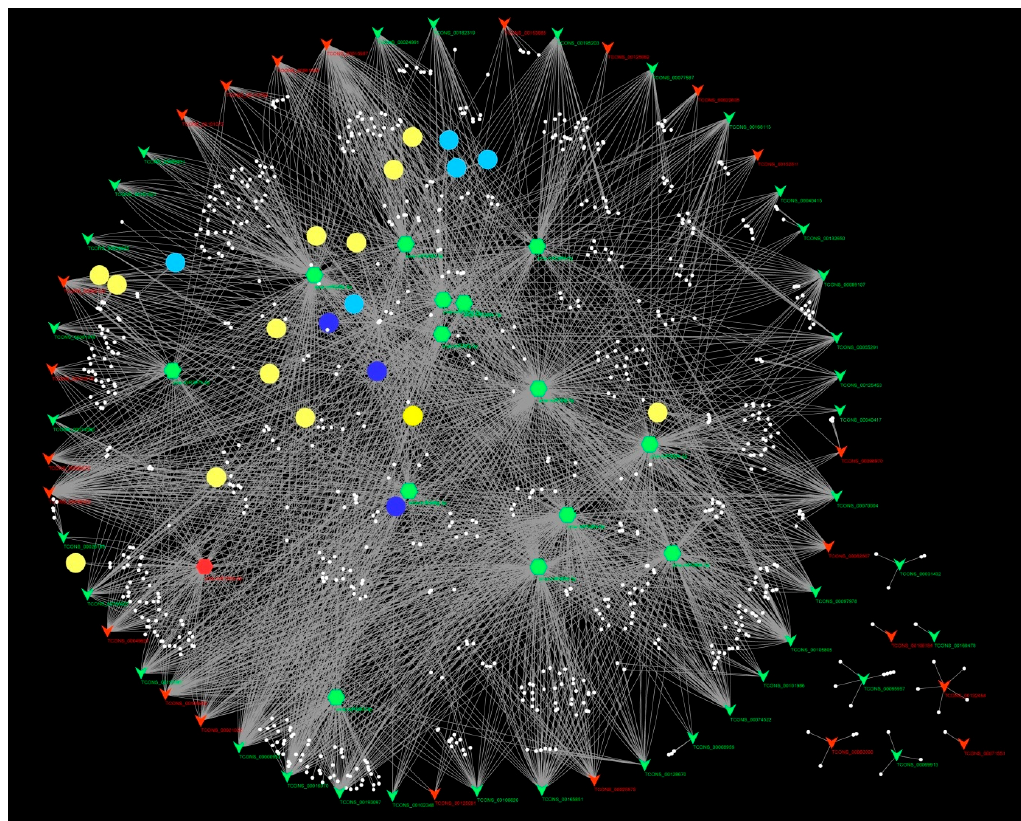
Figure 8. The potential regulating network of arbuscular mycorrhiza (AM)-responsive lncRNAs in maize root. Red inverted triangles represent up-regulated lncRNAs; green inverted triangles represent down-regulated lncRNAs; red hexagons represent up-regulated miRNAs; green hexagons represent down-regulated miRNAs; blue circles represent fatty acid metabolism-related pathways; cyan circles represent phosphate uptake-related pathways; yellow circles represent the rest of the enriched pathways; and white small circles represent the target genes.